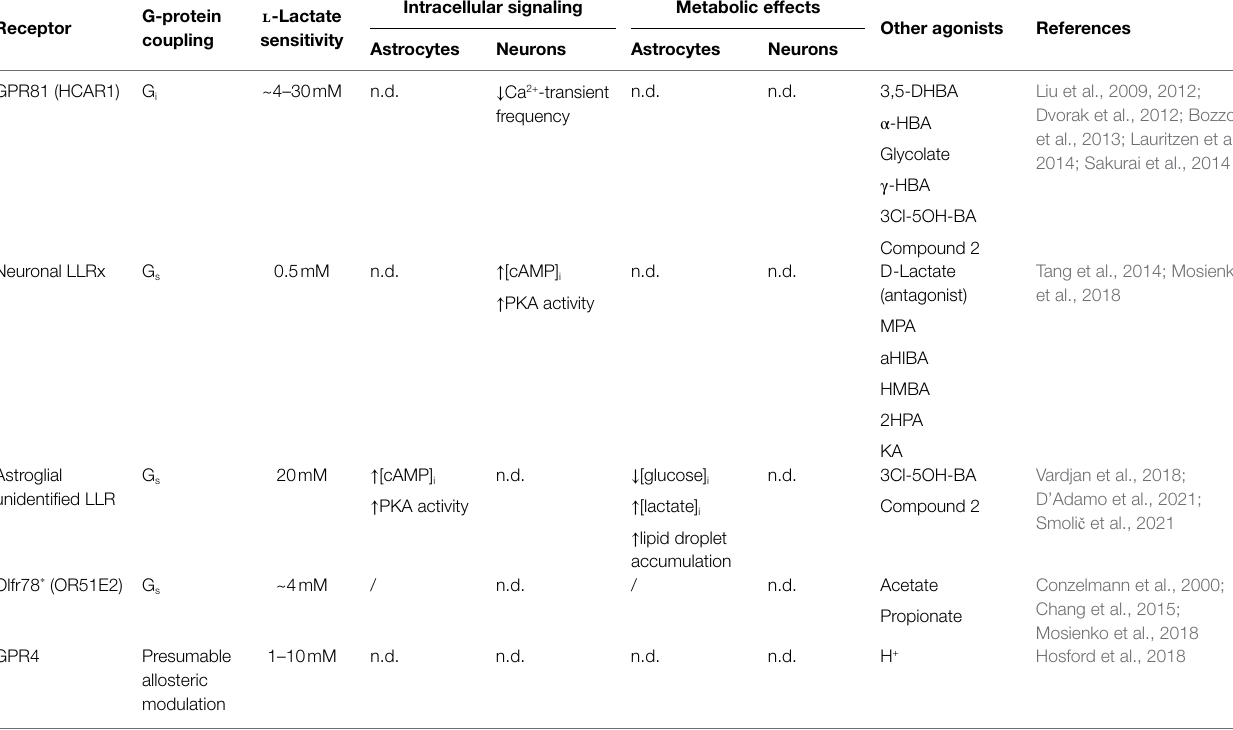
TABLE 1 | Astroglial and neuronal l -lactate-sensitive receptors and their effects on intracellular signaling and metabolism. G-protein Receptor